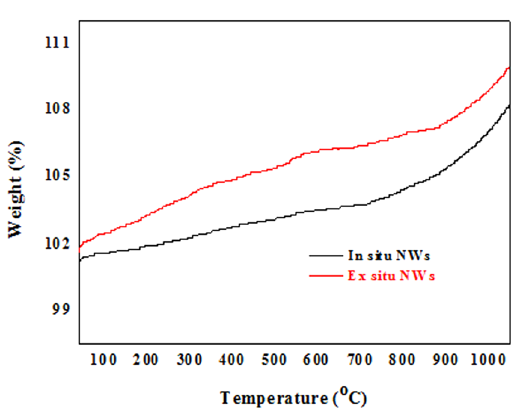
Figure 6. TGA curve of the SiC NWs in air at temperatures ranging from 100 °C to 1000